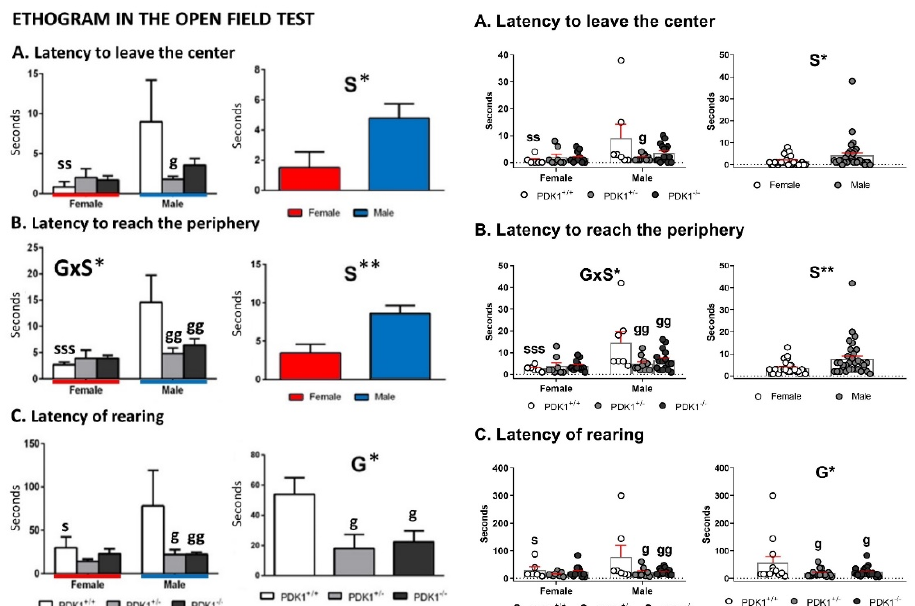
Figure 3. Ethogram in the open-field test in female and male mature PDK1 − / − , heterozygous PDK1 +/ − and homozygous WT (PDK1 +/+ ) mice. (( A – C ) Left panel ): Data are expressed as mean ± SEM or incidence. Bars illustrate the genotype groups. (( A – C ) Right panel ): Individual data are depicted. Factorial analysis: G, genotype effect; S, sex effect, * p < 0.05, ** p < 0.01. Post-hoc test: genotype: g p < 0.05, gg p < 0.01 vs. the corresponding WT (PDK1 +/+ ) group; s (sex), s p < 0.05, ss p < 0.01, sss p < 0.001 vs. the corresponding male of the same genotype.